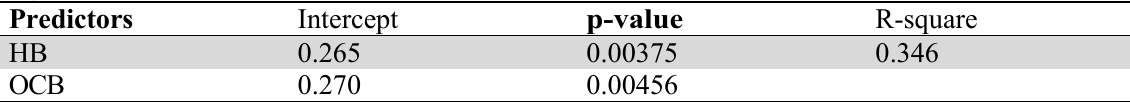
Regression analysis